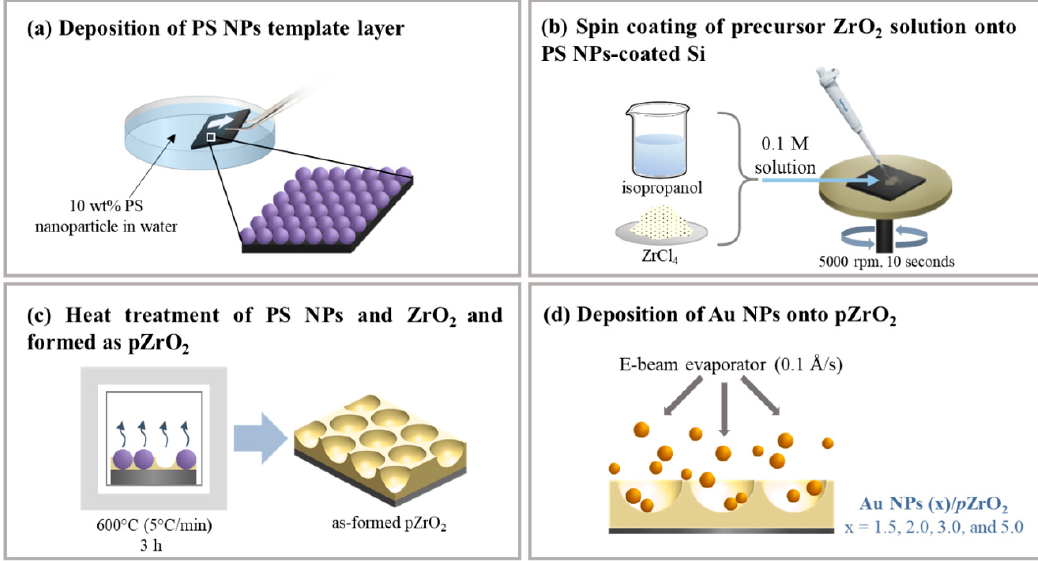
Scattering (SERS) substrates: ( a ) Formation of the pore template through deposition of monolayered polystyrene nanoparticles onto the Si substrate; ( b ) deposition of a precursor solution which is a mixture of isopropanol and ZrCl 4 through spin coating; ( c ) simultaneous removal of PS NPs and calcination of ZrO 2 through heat treatment; ( d ) thermal evaporation of Au nanoparticles onto the already-made p ZrO 2